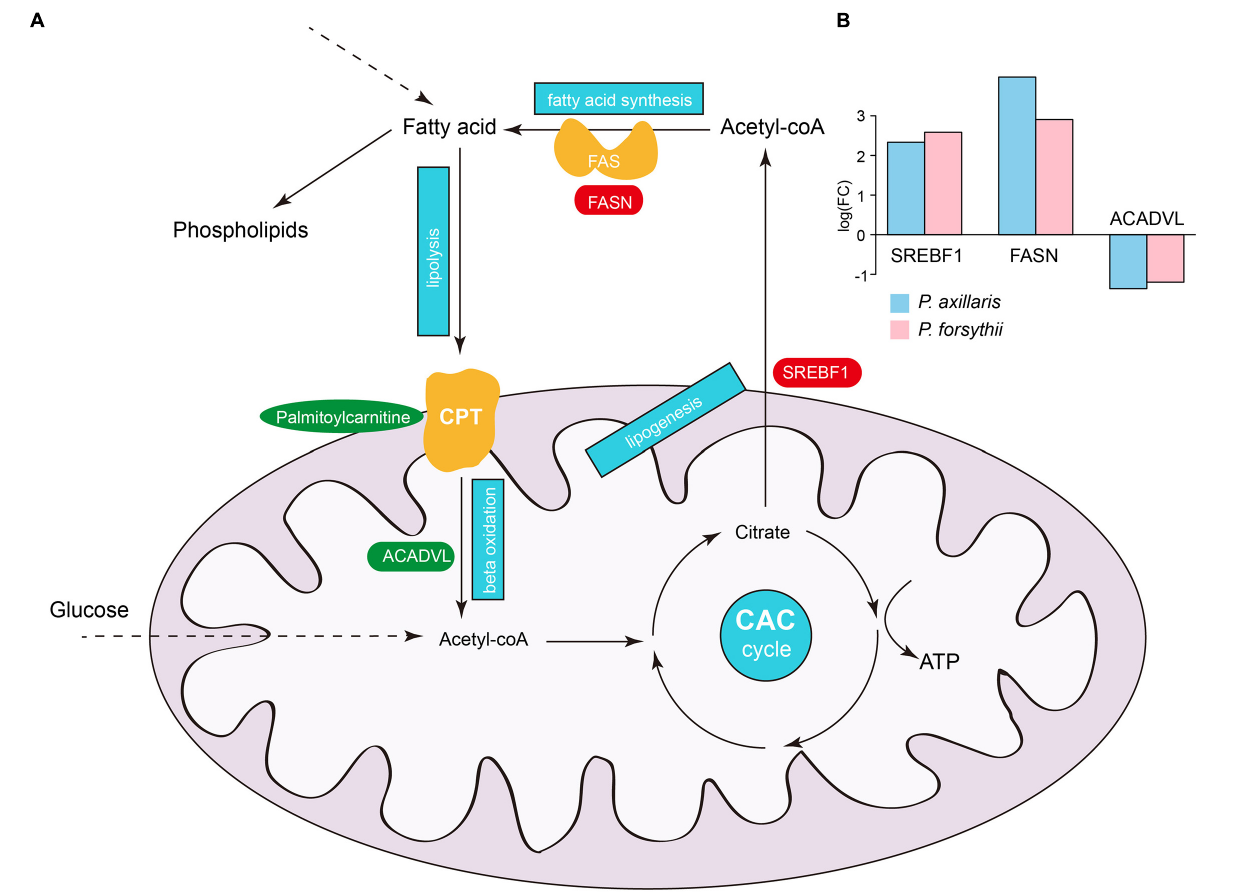
FIGURE 4 | Plasticity in fatty acid metabolism. (A) A schematic illustration of fatty acid metabolism in organisms. The blue frames represent the important biological processes in the pathway: lipolysis, beta-oxidation, lipogenesis, citric acid cycle (CAC), and fatty acid synthesis. Crucial genes and metabolites in the pathway are indicated by red or blue colors, which represent upregulation and downregulation of genes or metabolites, respectively. (B) The expression fold-change of SREBF1, FASN, and ACADVL in P. axillaris and P. forsythii .